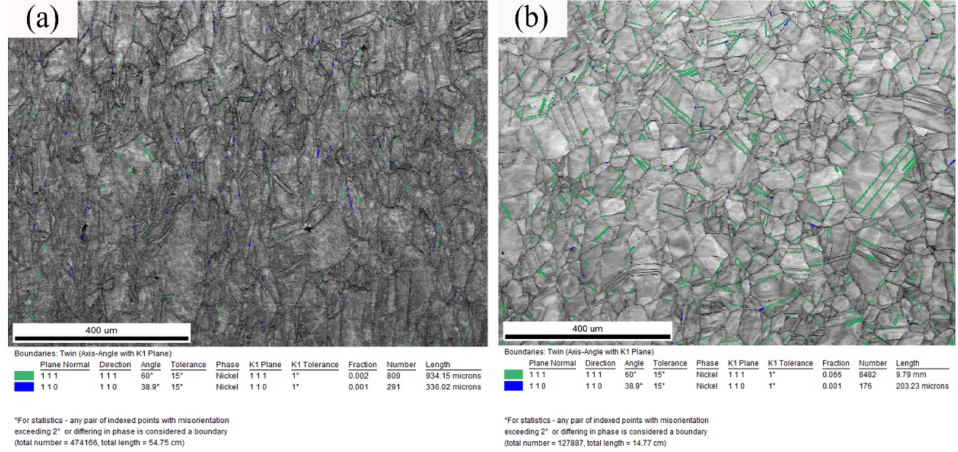
Figure 8. SEM micrographs of samples obtained by stretching at different temperatures ( a ) 400 ◦ C, ( b ) 600 ◦